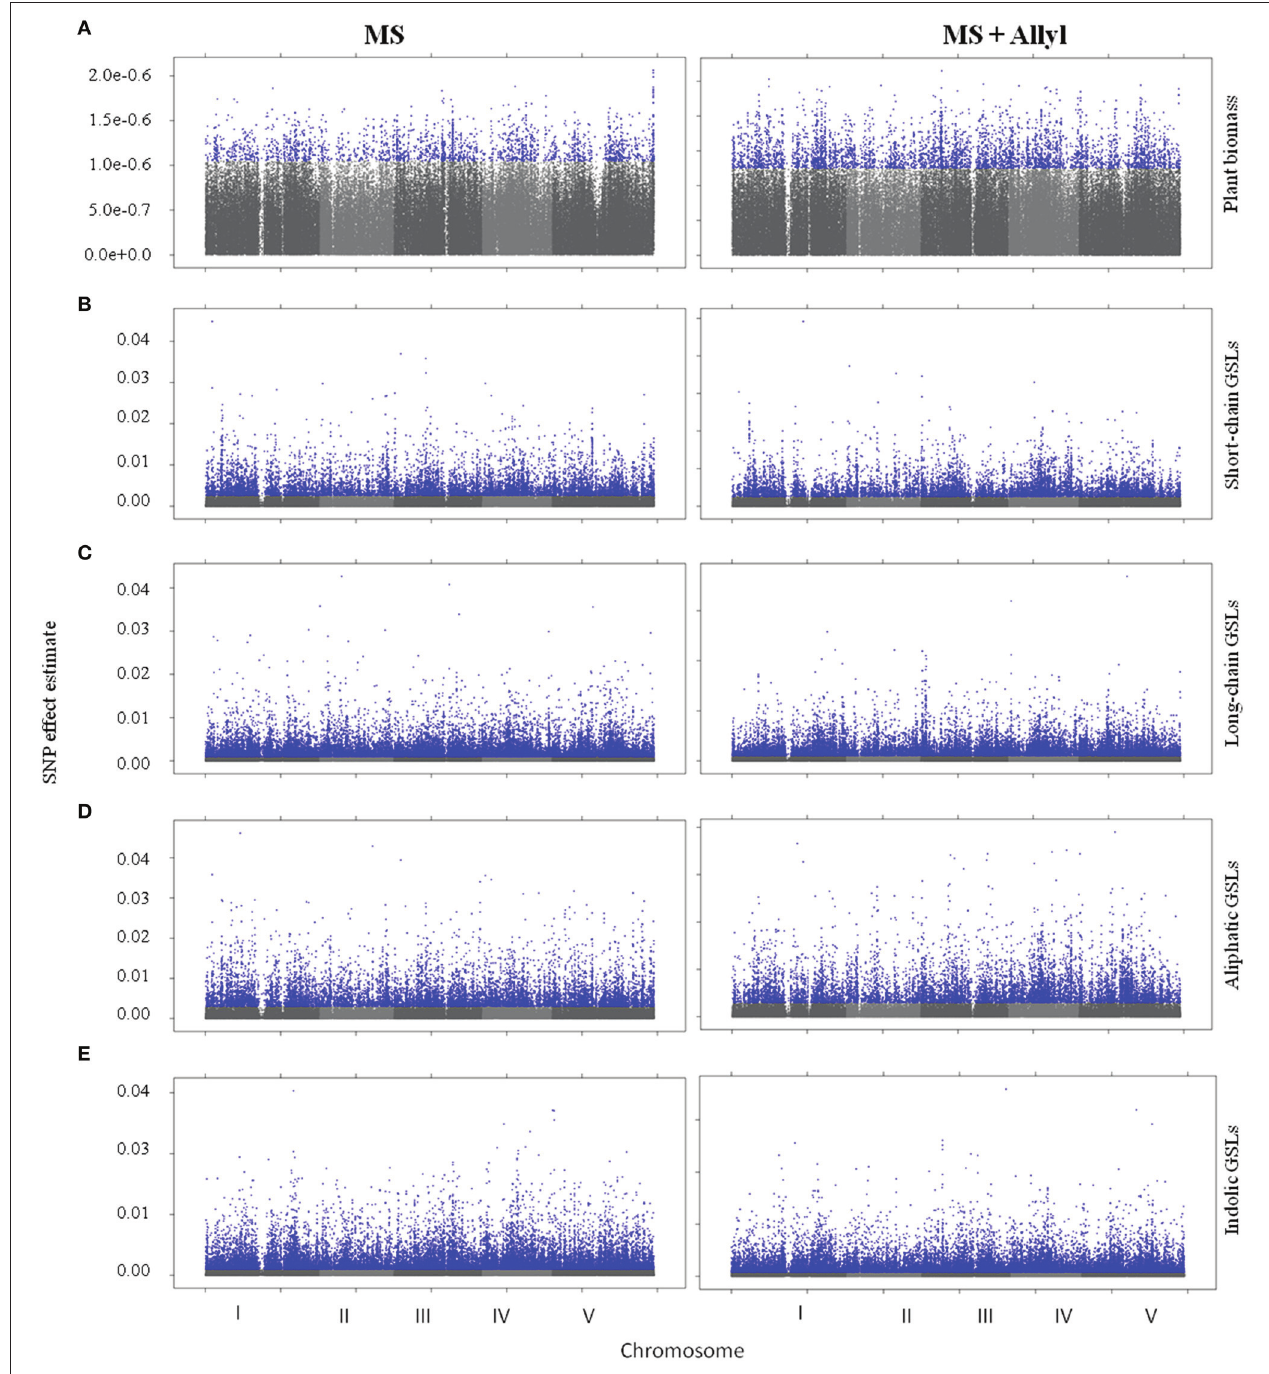
FIGURE 3 | Manhattan plots of GWAS results. Genome wide distribution of the absolute value of the heteroscedastic SNP effects. Shades of gray represent nonsignificant SNP effects. Blue points represent significant SNP effects under control (MS) and allyl treatment (MS + Allyl). (A) Plant Biomass, (B) Short-Chain GSLs, (C) Long-Chain GSLs, (D) Aliphatic GSLs, (E) Indolic GSLs.